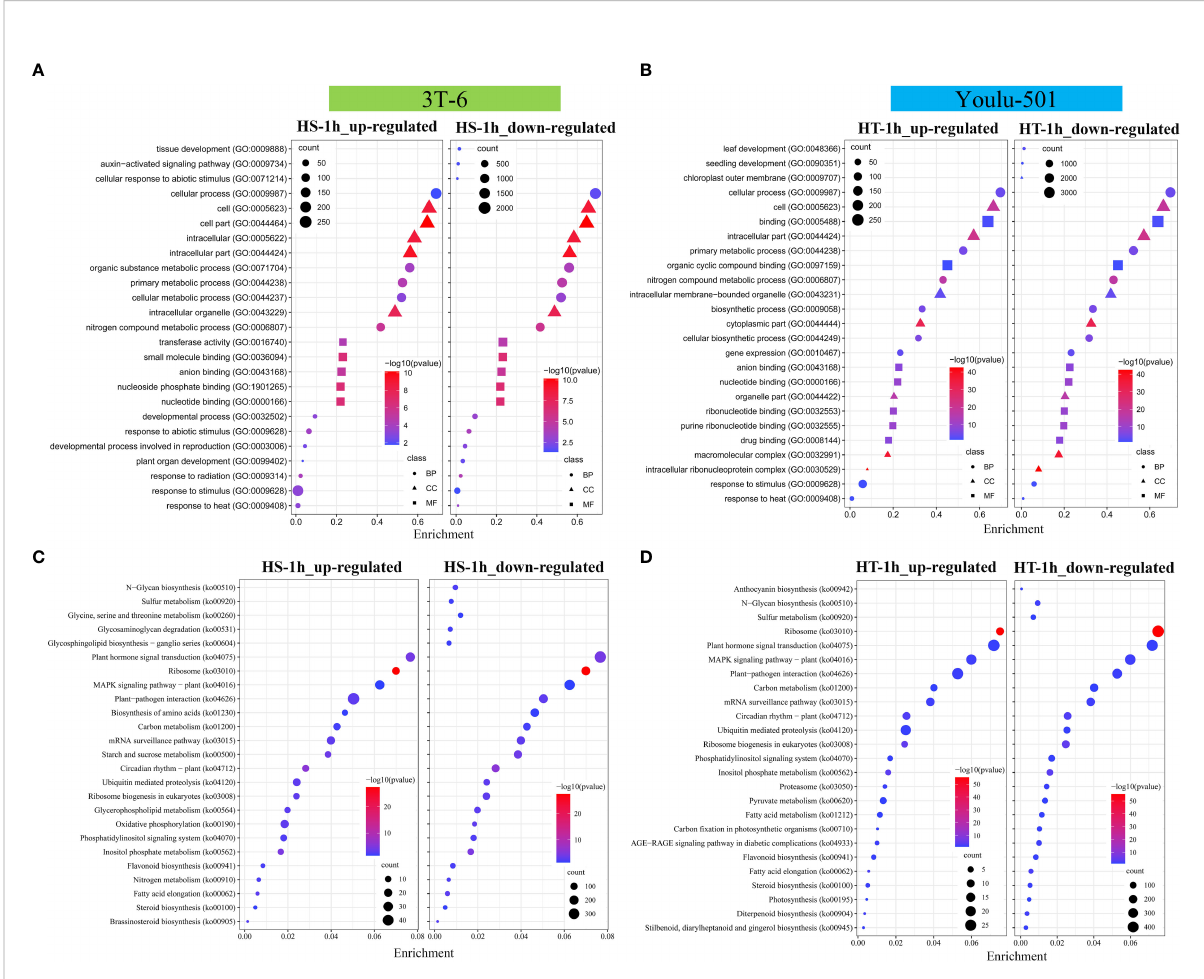
FIGURE 3 GO and KEGG enrichment analysis of up- and down-regulated genes in heat-sensitive (3T-6) and heat-tolerant (Youlu-501) fl owering Chinese cabbage. (A, B) The top 25 GO terms in three categories are listed at HS-1h vs. HS-CK and HT-1h vs. HT-CK at P ≤ 0.05; (C, D) The top 25 KEGG pathways and their corresponding number of genes HS-1h vs. HS-CK and HT-1h vs. HT-CK at P ≤ 0.05. The x-axis represents the enrichment factor, the y-axis represents GO/KEGG terms with the number of genes, and the blue to red color indicates the signi fi cance and number of